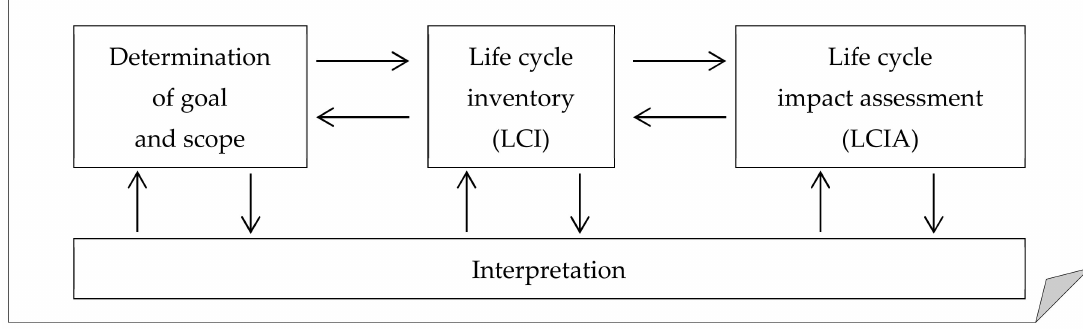
Figure 1. Life Cycle Assessment (LCA)